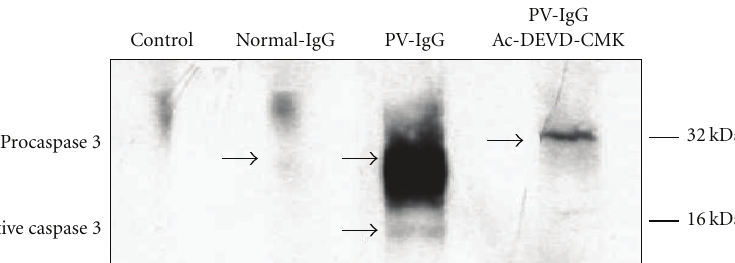
Figure 3: Mouse skin extracts were analysed using western blot and probed with a monoclonal anticaspase 3 antibody. The first line is a negative control incubated without antibody. The second line corresponds to a skin extract from a mouse injected with normal IgG. Note that a faint band appears at 32 kDa which corresponds to caspase 3 zymogen. The third line corresponds to an animal injected with pemphigus vulgaris IgG and shows a large band of pro-caspase 3 and an additional band at 16kDa, which corresponds to active caspase 3. The skin extract from the mouse treated with Ac-DEVD-CMK and injected with pemphigus IgG exhibited only the proenzyme.